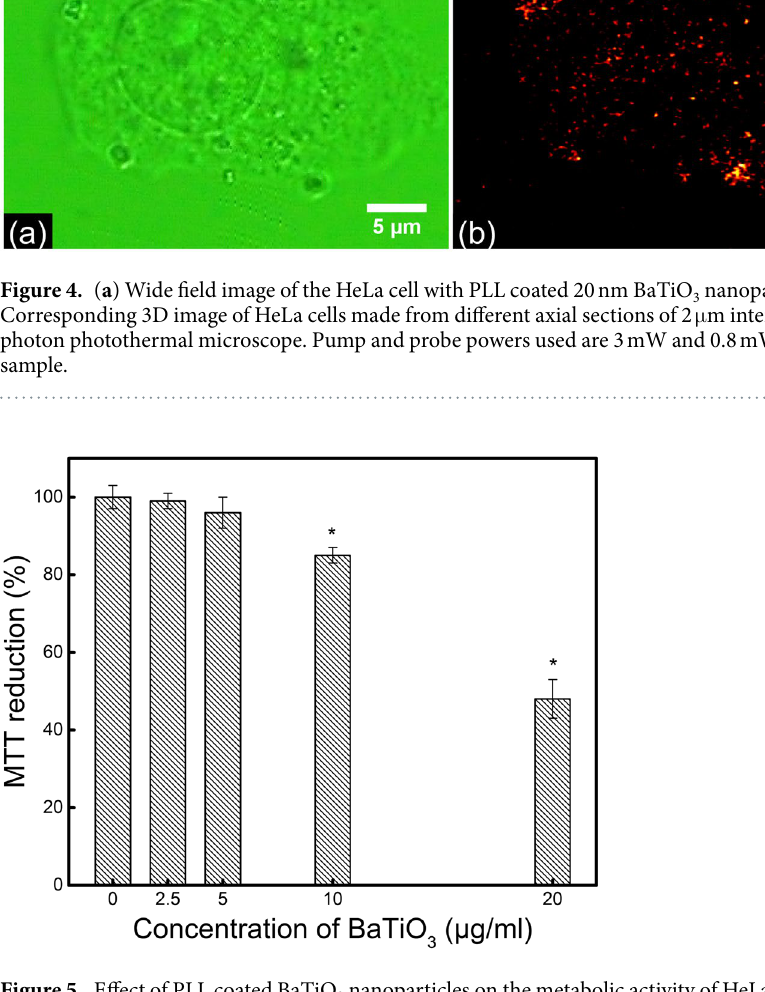
Figure 5. Effect of PLL coated BaTiO 3 nanoparticles on the metabolic activity of HeLa cell as measured by MTT assay for various concentrations. Data is represented as mean ± standard error mean of three independent experiments. P < 0.05 is indicated with a *